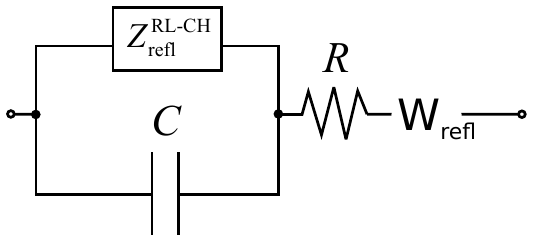
Figure 7. Equivalent circuit model of PANI-MWCNT pseudo-capacitor. Element Z RL impedance from (22) for the case of the RL-CH model with reflecting boundary